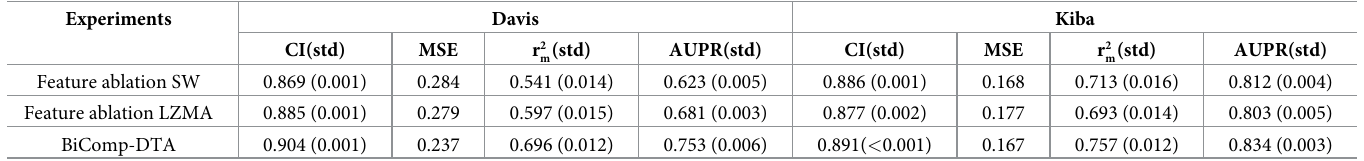
Table 9. Performance comparison of BiComp encoding, against LZMA and SW encodings, for drug-target binding affinity prediction, for Davis and Kiba datasets, using feature ablation experiments. Experiments Davis Kiba Feature ablation